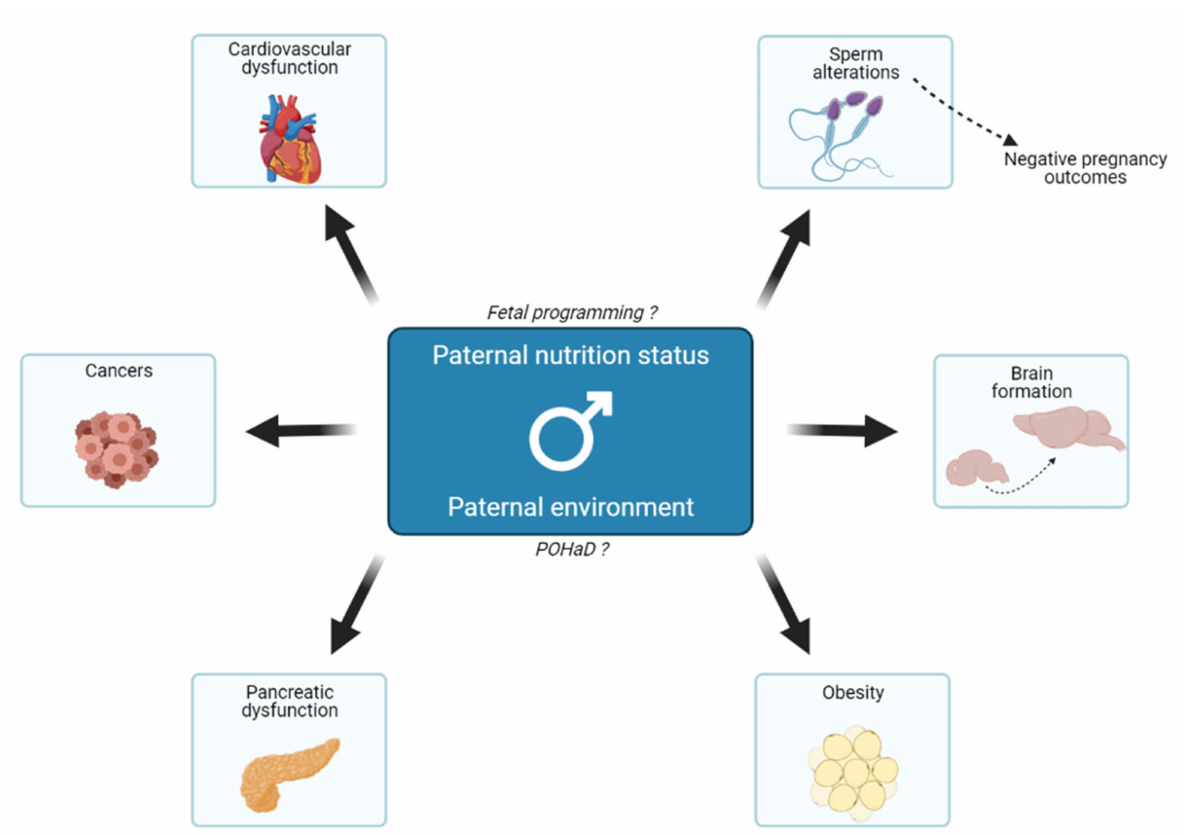
Figure 2. Effects of paternal nutrition status and environment on their offspring. The paternal nutritional status can act on offspring’s growth and metabolism and, therefore, its predisposition to various diseases in adulthood. That is related to the fetal programming hypothesis because fathers act indirectly on fetal growth. Besides, in the same way as the DOHaD theory, the POHaD paradigm suggests that the paternal environment could also influence the offspring’s metabolic changes. Mechanisms underlying all these events are poorly understood, but emerging evidence suggests that it could be transmitted through the sperm epigenome, notably in the case of negative pregnancy